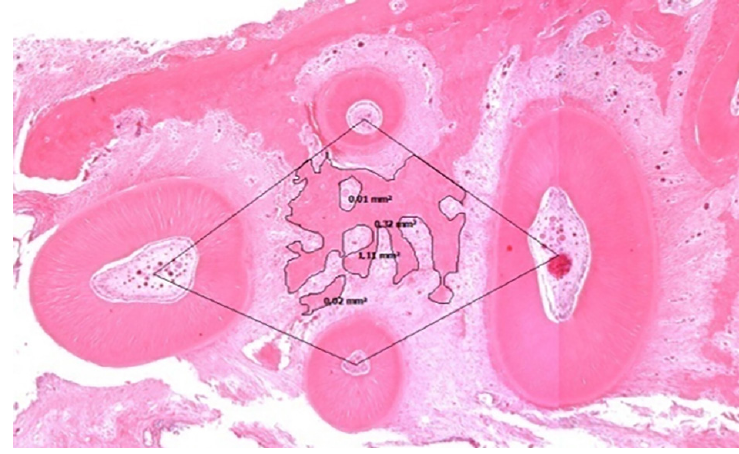
Cross-section of the first molar mandibular with geometric area and total amount of bone outlined. Figure 2- Delimitation of histomorphometric